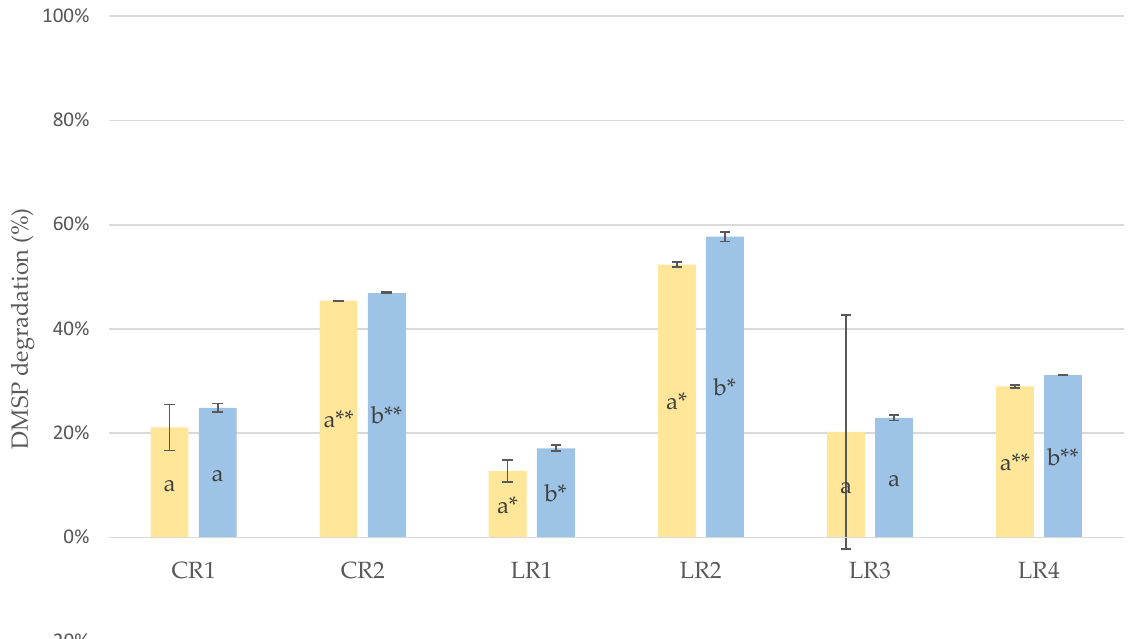
Figure 3. Percentage of DMSP degradation after three months of accelerated bottle ageing depending on closure 1 (OTR = 0.19 mg O 2 /year) and closure 4 (OTR = 1.79 mg O 2 /year) for each wine sample (a and b: a different letter means there is a significant difference between the two groups; **: significant difference at 5%; *: significant difference at 10%).